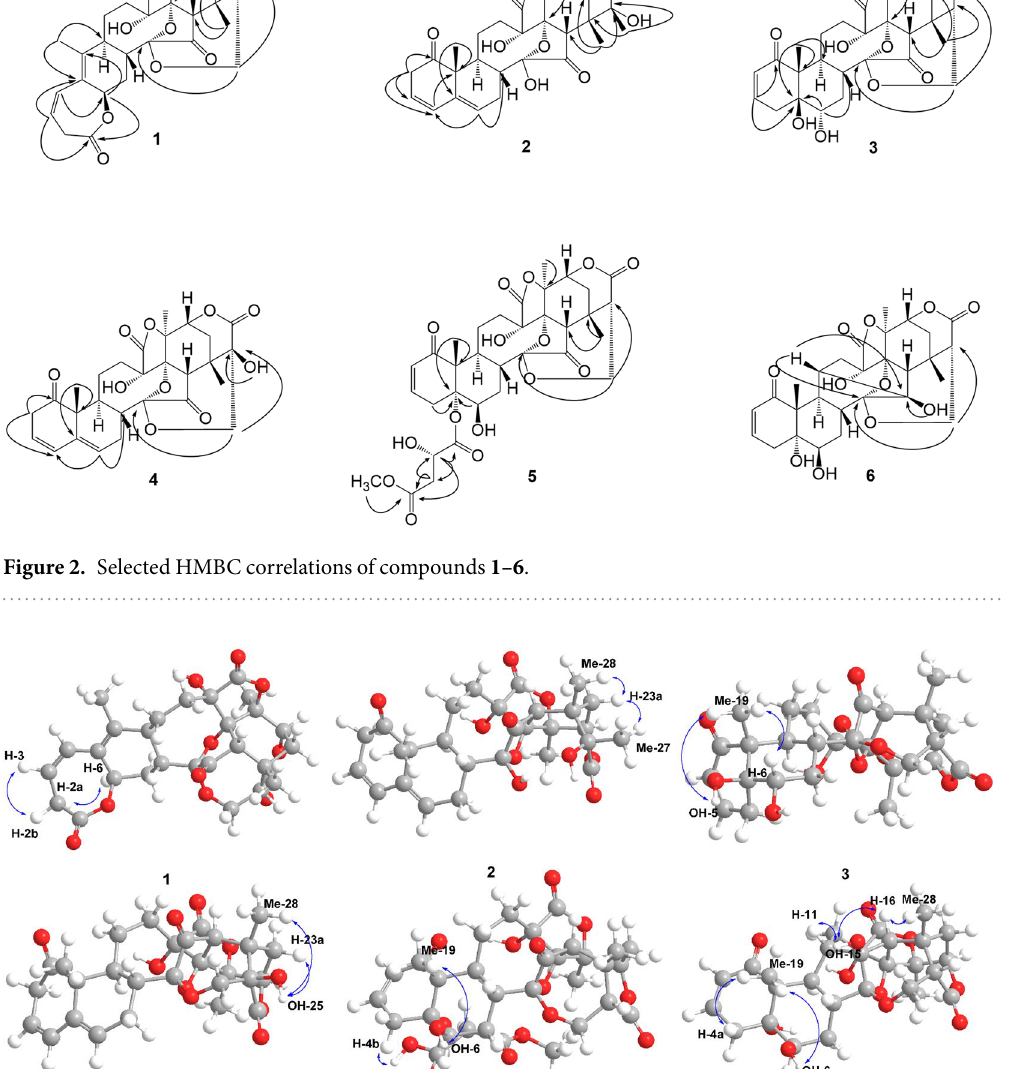
(3 H, s, Me-27), and 1.17 (3 H, s, Me-19), and the reduced two geminal oxymethylene protons in conjunction with the 13 C NMR data [ δ C 209.6 (C-1), 140.4 (C-5), 128.0 (C-4), 126.6 (C-6), 122.6 (C-3), 101.0 (C-14), 22.4 (C-28), 20.7 (C-21), 19.4 (C-27), and 17.8 (C-19)], indicating the existence of a 1-oxo-3,5-diene unit and the nonexistence of a C(14)-O-C(27) cyclization moiety. The above NMR spectroscopic data of 2 were related to those of physalin M isolated from P . alkekengi L. var. franchetii 35 , except for the presence of a methyl group [ δ H 1.36 (3 H, s, Me-27); δ δ C 19.4 (C-27)] and an oxygenated carbon [ C 72.6 (C-25)], with the assumption for the presence of a hydroxy group at C-25. The key HMBC correlations from Me-27 to C-24/C-25/C-26 and Me-28 to C-16/C-23/C-24/C-25 (Fig. 2 and Supplementary Fig. 12–14) confirmed the hypothesis. The orientation of OH-25 was deduced to be α by NOESY correlations of Me-27 with H-23a and Me-28 with H-23a (Fig. 3 and Supplementary Fig. 15 and 16). Therefore, 2 was determined as (8 R ,9 S ,10 R ,13 S ,14 R ,16 S ,17 R ,20 S ,22 R ,24 S ,25 R )-25-hydroxyphysalin M. Physalin D 1 ( 3 ) had the molecular formula C 28 H 32 O 11 identified by HRESIMS m/z 543.1870 [M − H] − (calcd for C 28 H 31 O 11 , 543.1866; Supplementary Fig. 26). Compound 3 exhibited the 1 H and 13 C NMR data (Supplementary Fig. 19–23) completely identical to those of physalin D 1 isolated from P . alkekengi L. var. franchetii 36 , indicating that they were the same compound. However, the NOESY spectrum of 3 displayed a key correlation between OH-5 and Me-19 (Fig. 3 and Supplementary Fig. 24 and 25), indicating a β -orientation of OH-5. This conclusion was further confirmed by the 13 C NMR chemical shift value of the methyl group at C-10 3 Scientific RepoRts | 7: 4057 | DOI:10.1038/s41598-017-03849-9